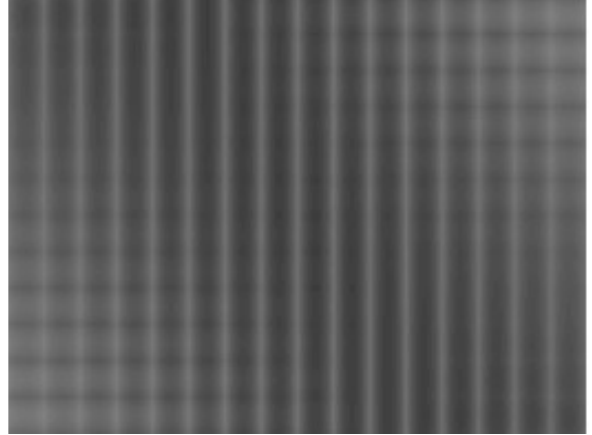
Figure 19. Difference (in pixels) according to y axis of image for each pixel between the projected point obtained by the precise mapping and the projected point obtained by the bilinear function between the 1 st and the 10 th image : Diff max = 0 . 0162 .